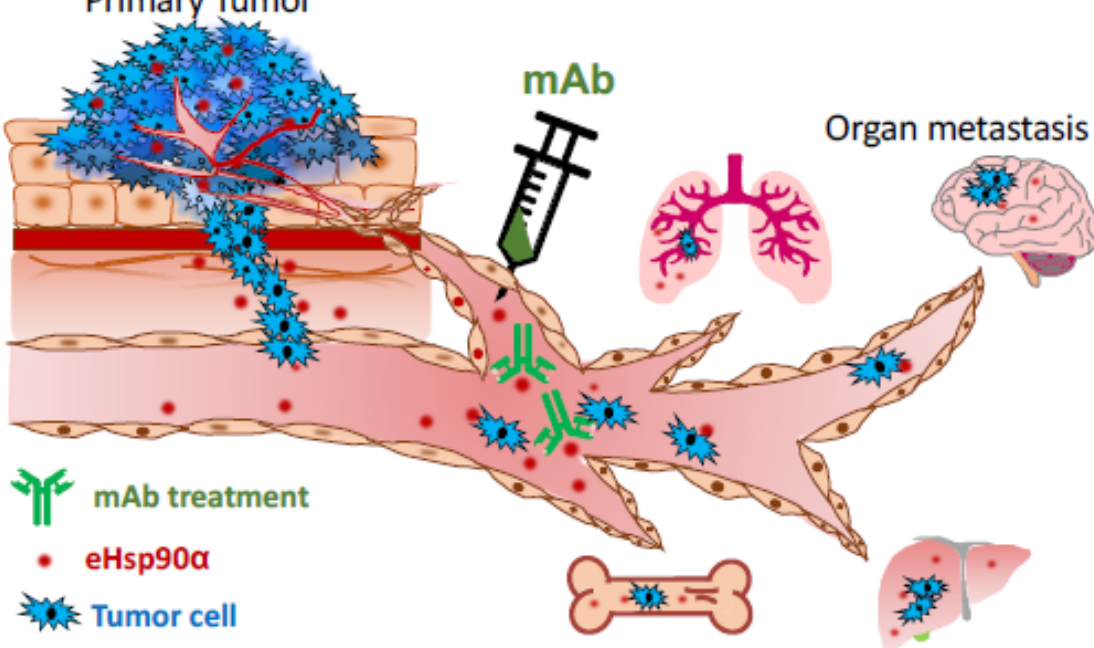
Figure 5. Plasma eHsp90 α as a potential target for therapeutics to block tumour metastasis. Findings of the clinical studies shown in Table 1 have raised an exciting possibility that monoclonal antibody therapeutics against plasma eHsp90 α block tumour metastasis. Since plasma eHsp90 α is low and unessential for homeostasis, targeting plasma eHsp90 α in cancer patients may prove to be safer and more effective than targeting the intracellular Hsp90 α and Hsp90 β .